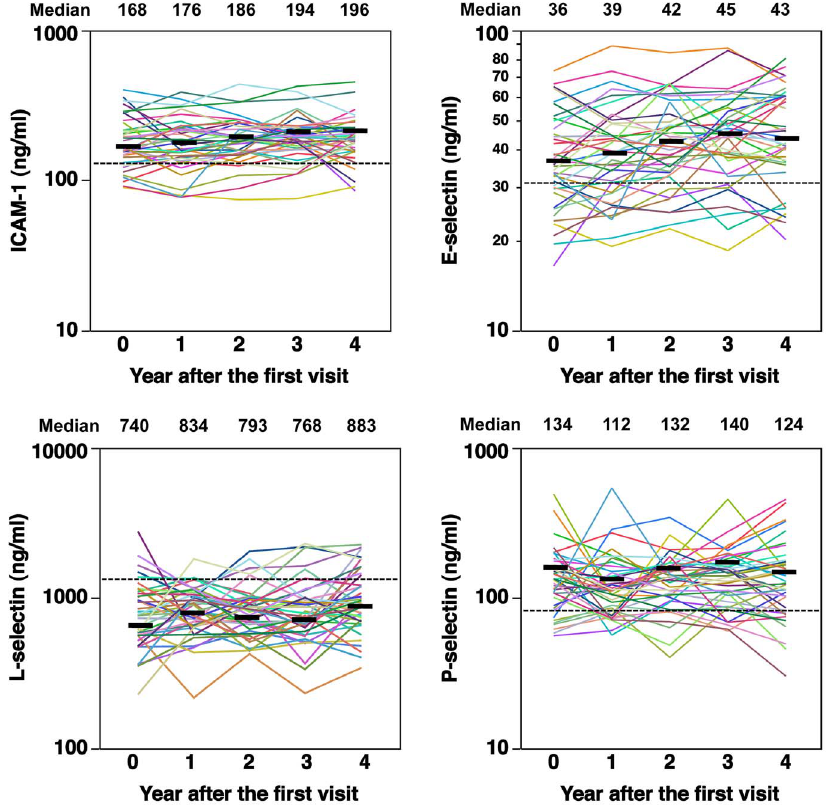
Figure 2. Longitudinal change of serum adhesion molecule levels in each patient during the four years of the study. The horizontal dotted line indicates the median value in healthy controls. The horizontal bar at each time point indicates the median value.